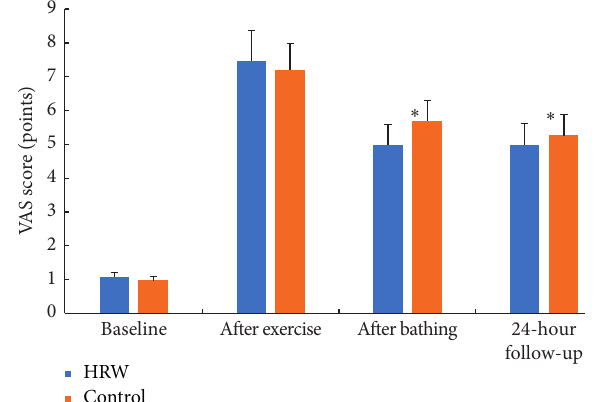
Figure 1: Visual Analogue Scale (VAS) scores for muscle soreness during the study. Asterisk ( ∗ ) indicates a significant difference between interventions (hydrogen-rich water, HRW vs. control bath) for a change from postexercise VAS scores at P < 0 .